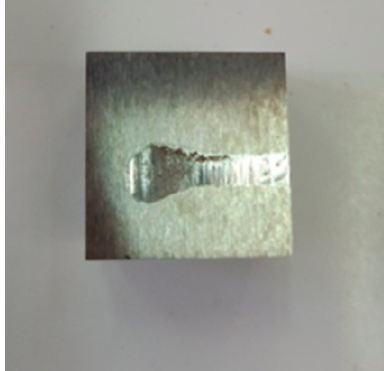
Figure 8. The temperature field in the area of the cast iron sample–granite roller interface during the wear test on the Baroid tester.